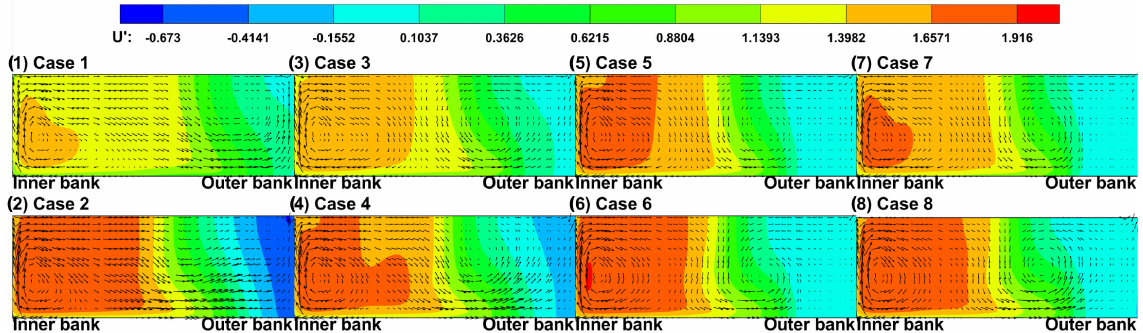
Figure 13. The contours of dimensionless streamwise velocity distribution and 2 ‐ D vectors on CS. 2 of all the cases.